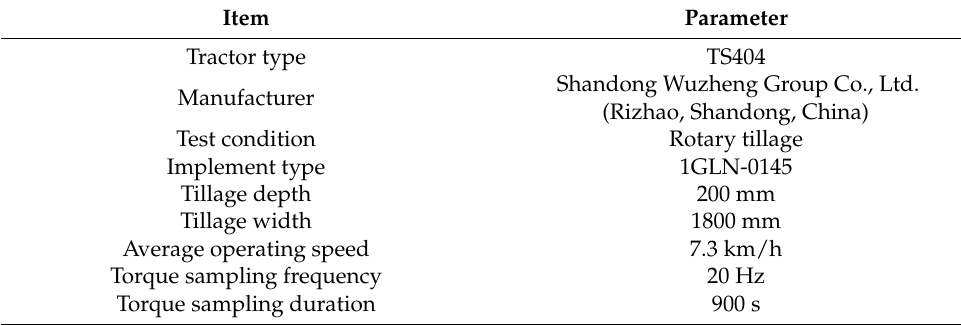
Table 1. Parameters of load spectrum acquisition